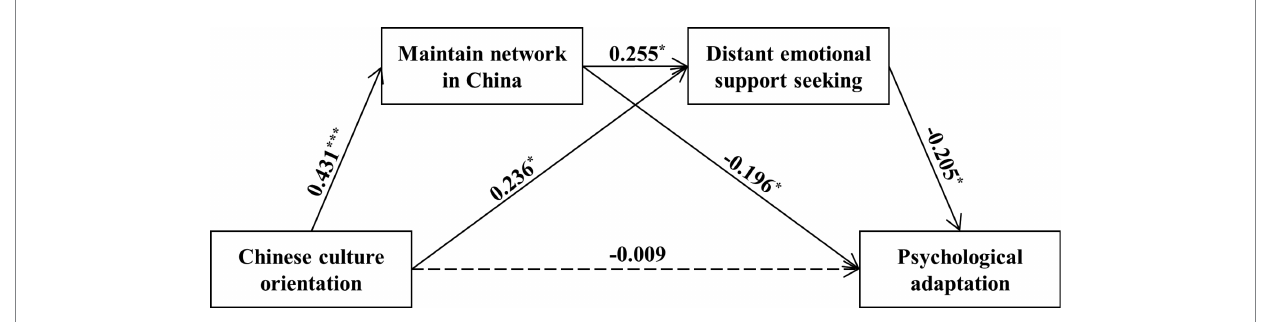
FIGURE 5 Mediation paths between Chinese-culture orientation and psychological adaptation to the U.S. via motivation to maintain network in China and distant emotional support-seeking. Gender, SES, and length of residence in the U.S. are included as covariates.